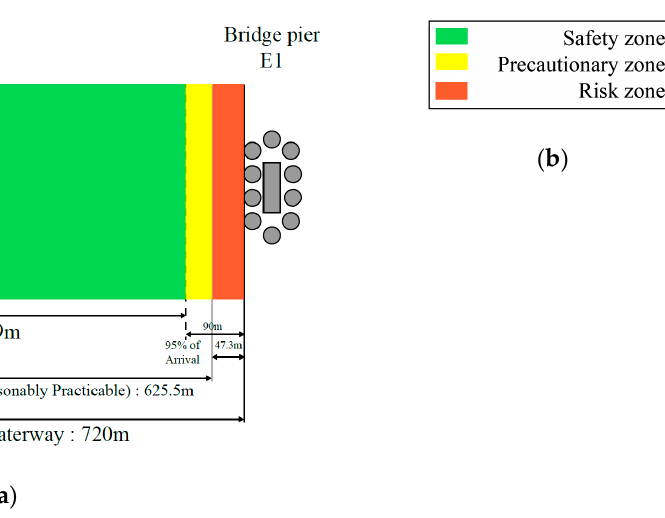
Figure 17. Ship safety distance for 2-way tra ffi c situation at the ( a ) Incheon bridge and ( b ) legend. For the Busan harbor bridge, the Safety zone according to tra ffi c distribution corresponding to the 95% confidence interval is 244 m, and it is within the 49.8% range based on the navigable waterway (490 m). The Precautionary zone is in the 21.6% range based on the navigable waterway, whereas the Risk zone is within the 28.6% range (Figure 18).